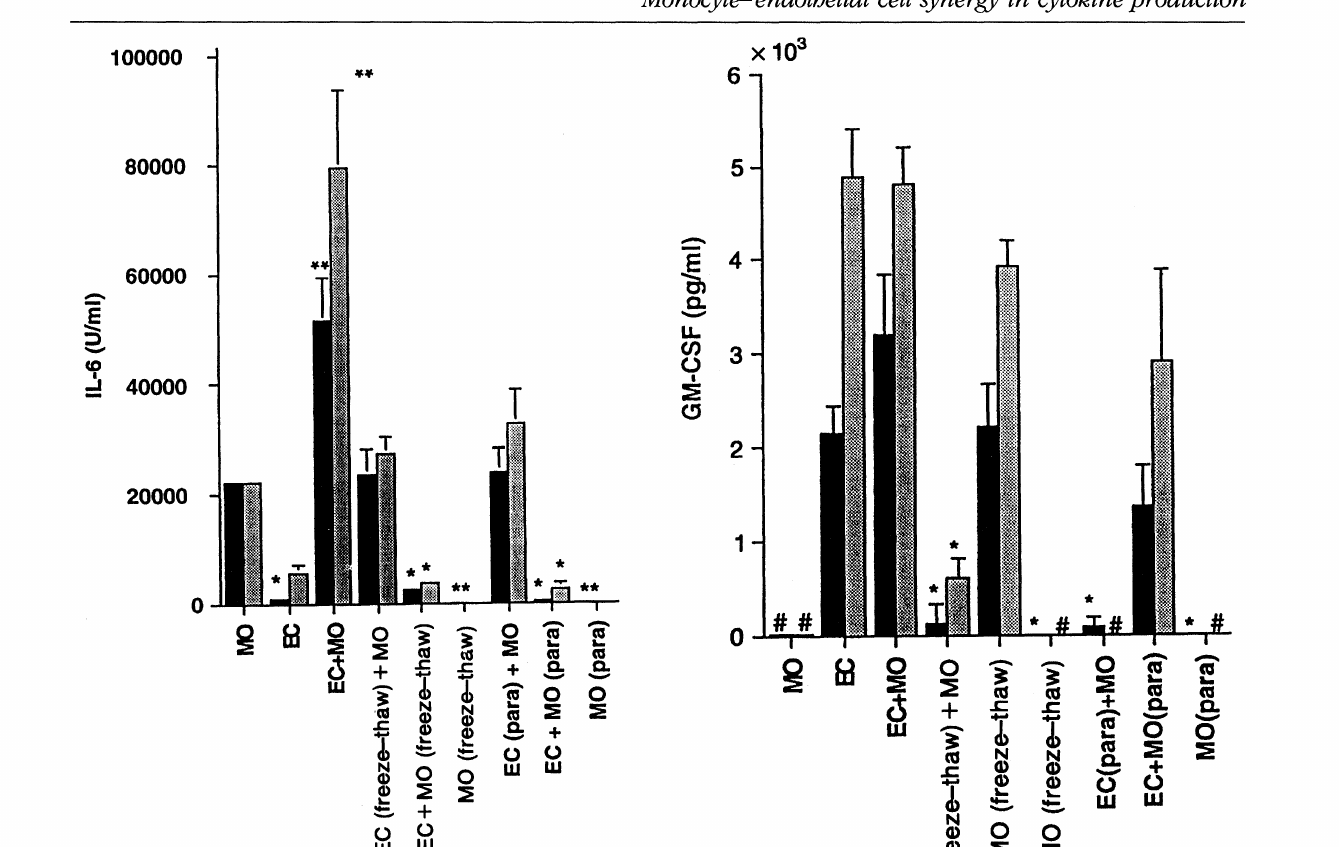
FIG. 3. Effect of prior lysis or fixation of either cell population on the production of IL-6 by EC:MO co-cultures. After treatment for 24h with either medium or PAF (10-1M)+TNF- (25U/ml), EC were washed and either fixed with paraformaldehyde FIG. 4. Effect of prior lysis or fixation of either cell population on (0.05%) for 30 min, or lysed by three cycles of freezing (liquid nitrogen) and thawing (37C). Thereafter EC were washed and the production of GM-CSF by EC:MO co-cultures. After treat- incubated with monocytes. Alternatively, monocytes were fixed ment for 24h with either medium or PAF (10-1M)+TNF- or lysed in the same manner and then washed and added to (25 U/ml), EC were washed and either fixed with paraformalde- hyde (0.05%) for 30 min, or lysed by three cycles of freezing intact EC. After 24h of co-culture, cell-free supernatants were harvested and assayed for IL-6 activity. Data represent mean -t- (liquid nitrogen) and thawing (37C). Thereafter EC were washed S.E.M. of three experiments. Statistically significant effects were and incubated with monocytes. Alternatively, monocytes were ,, noted as: *p < 0.0001" **p < 0.0005, in comparison to mono- fixed or lysed in the same manner and then washed and added cytes alone. Medium; [], TNF. to intact EC. After 24 h of co-culture, cell-free supernatants were harvested and assayed for GM-CSF activity. Data represent mean -t- S.E.M. of three experiments. Statistically significant ,, effects were noted as: *p < 0.005; #p < 0.0005, in comparison to EC alone. Medium; [], PAF and